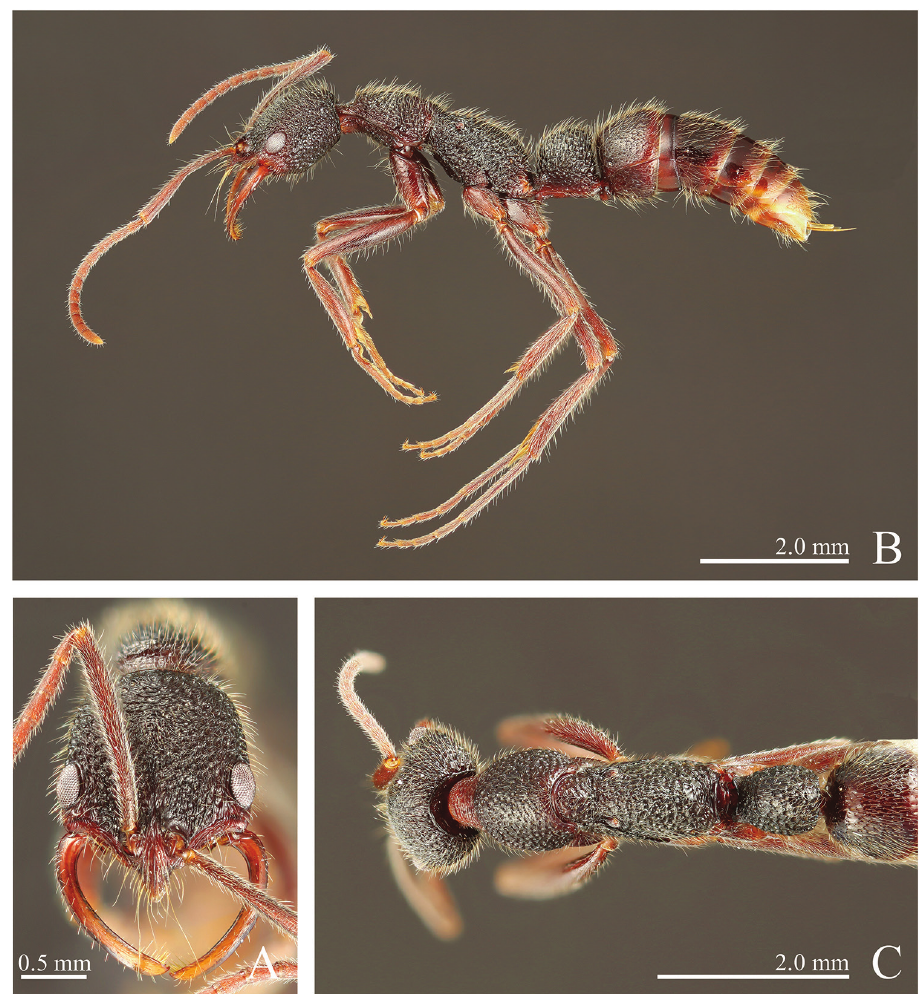
Figure 11. Leptogenys kanaoi sp. n., holotype, worker. A head, full-face view B lateral view C dorsal view. forming continuous curve with dorsum; dorsal face sloping anteriad. Gastral segment II